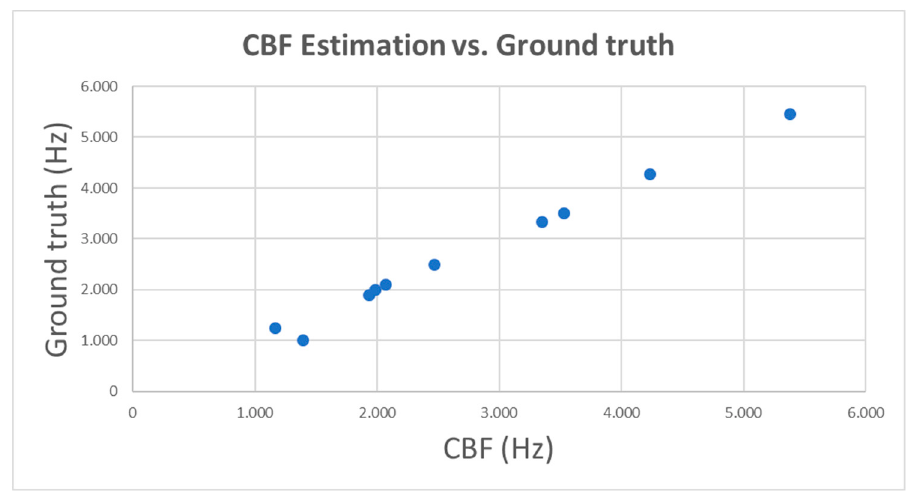
Figure 9. Scatter plot of CBF Estimation versus Ground truth.